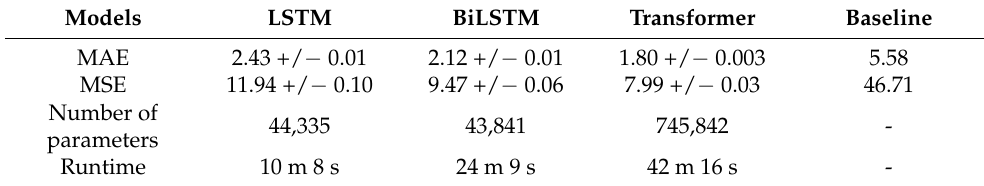
Table 3. Mean Error (knots) on test data of the selected